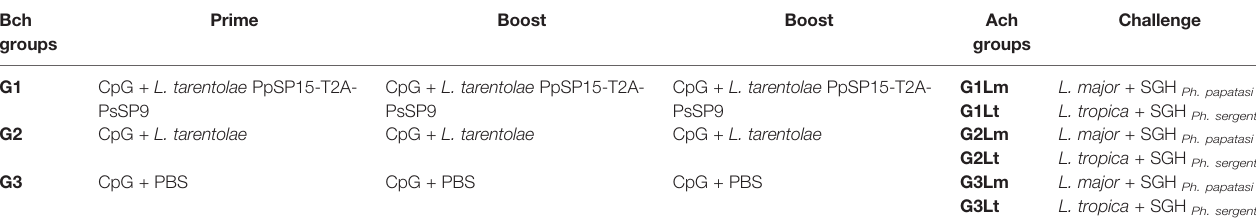
TABLE 1 | Vaccination regimens in BALB/c mice